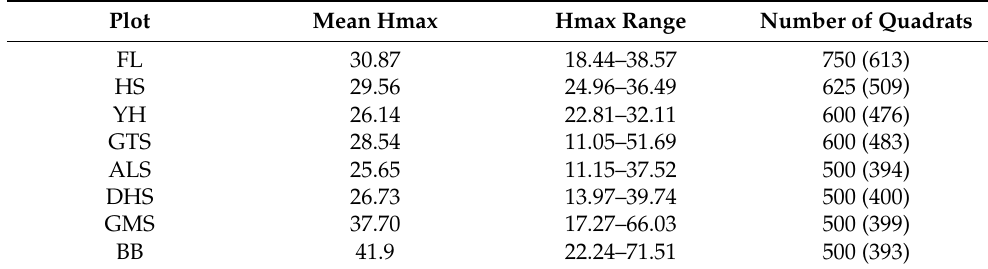
left after removing the boundary quadrats and the quadrats with the 5% lowest Hmax.